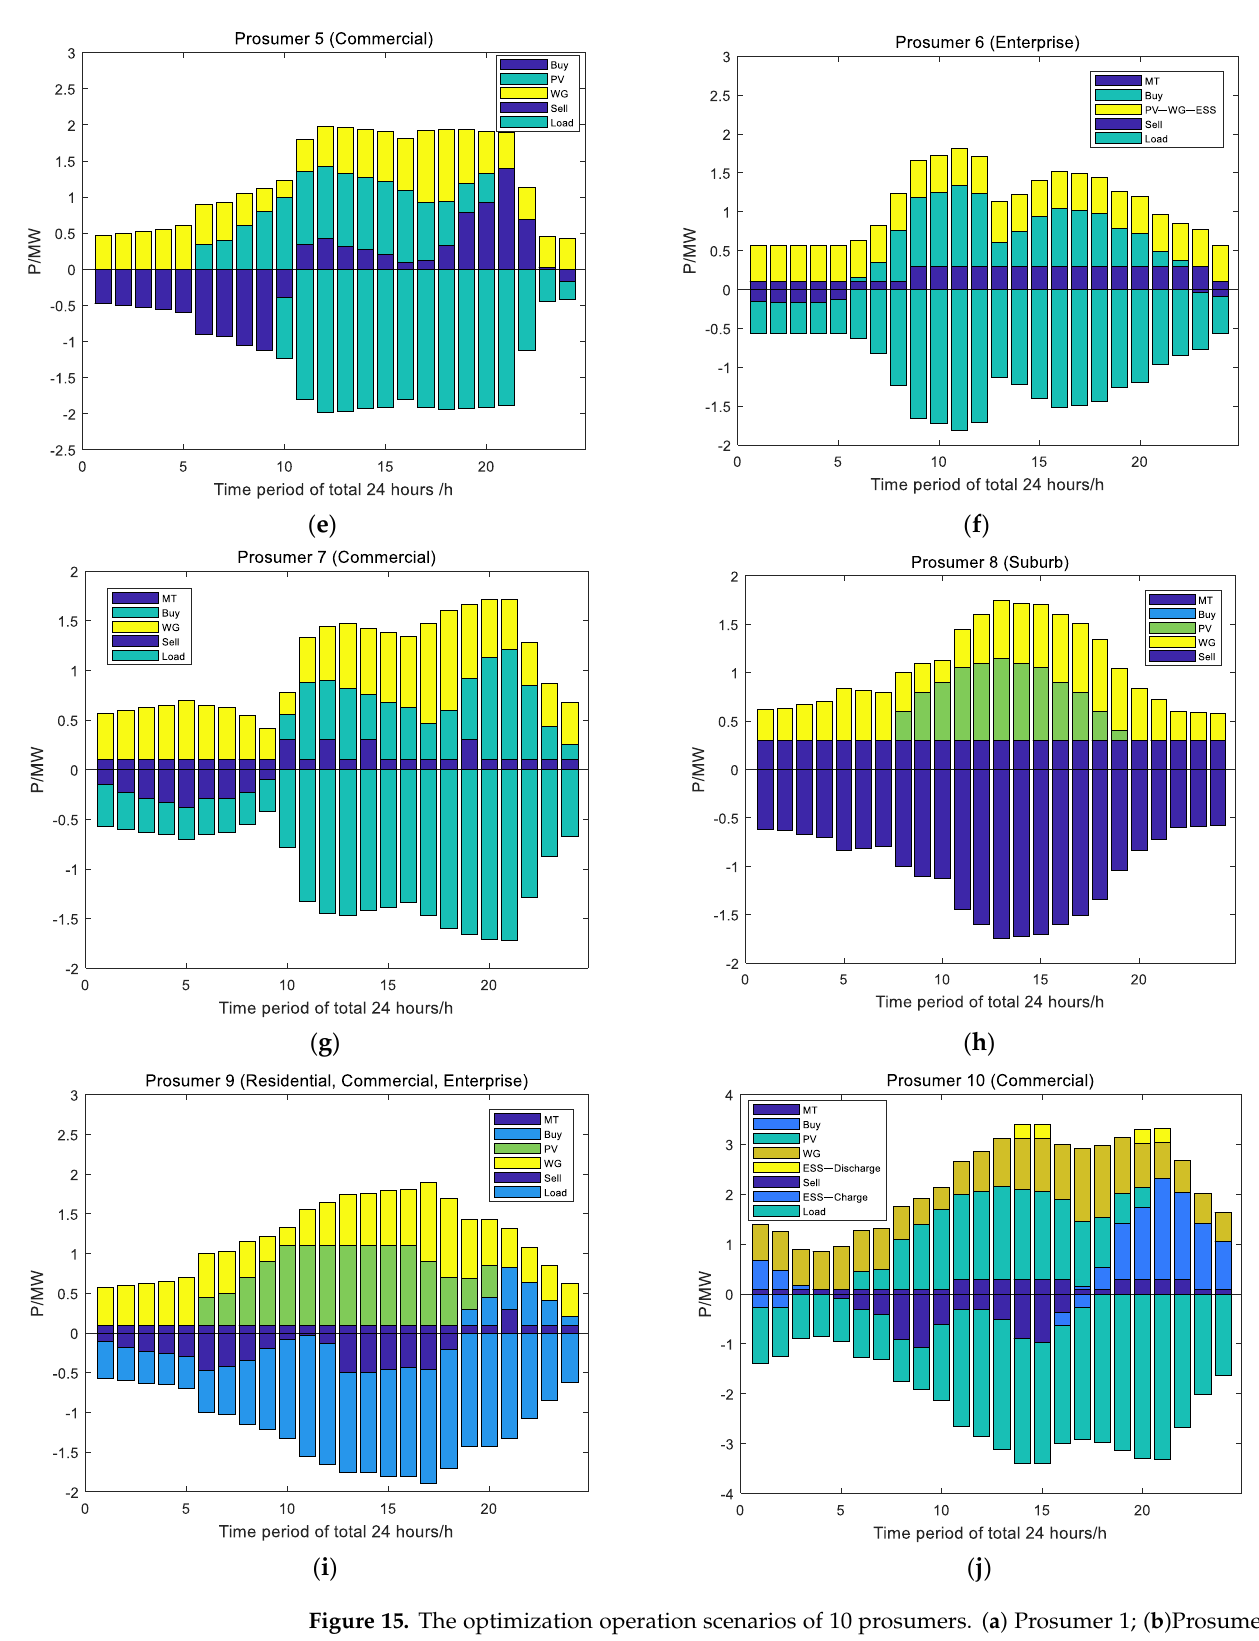
Figure 15. The optimization operation scenarios of 10 prosumers. ( a ) Prosumer 1; ( b ) Prosumer 2; ( c ) Prosumer 3; ( d ) Prosumer 4; ( e ) Prosumer 5; ( f ) Prosumer 6; ( g ) Prosumer 7; ( h ) Prosumer 8; ( i ) Prosumer 9; ( j ) Prosumer 10.